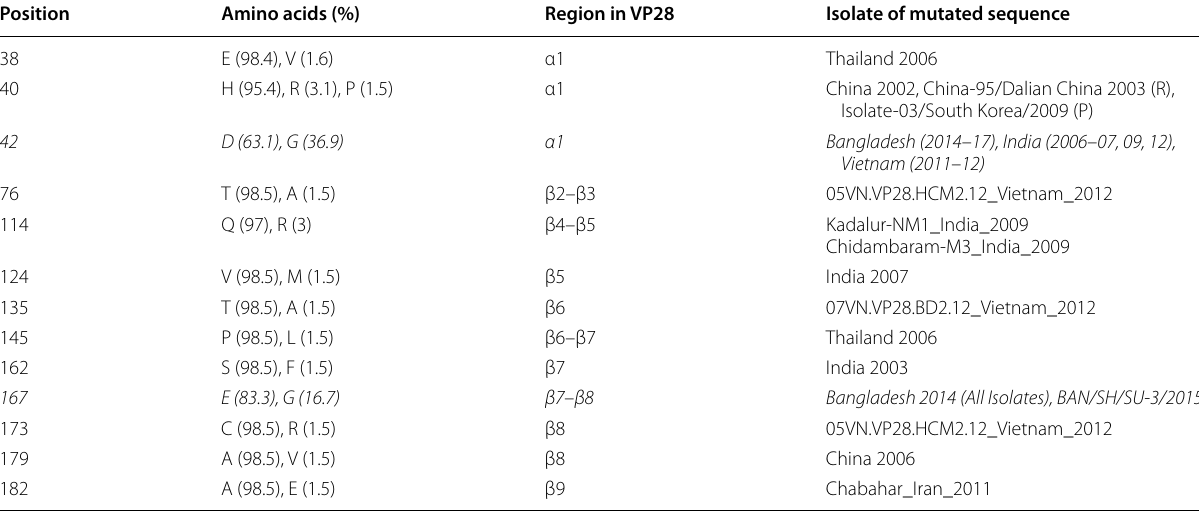
Table 2 Amino acids in the mutated positions showing the percentage along with position and region name of WSSV VP28